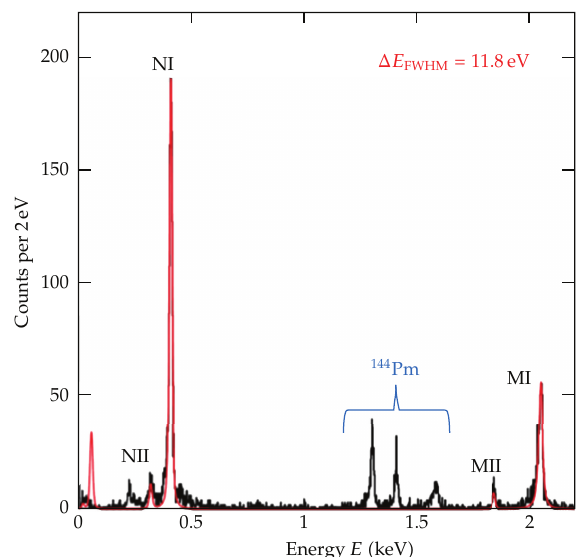
Figure 33: Calorimetric energy spectrum for electron capture decays of 163 Ho. The peaks around 1.5 keV originate from 144 Pm decays. 144 Pm was present as an admixture in the implantation beam (figure courtesy of Gastaldo